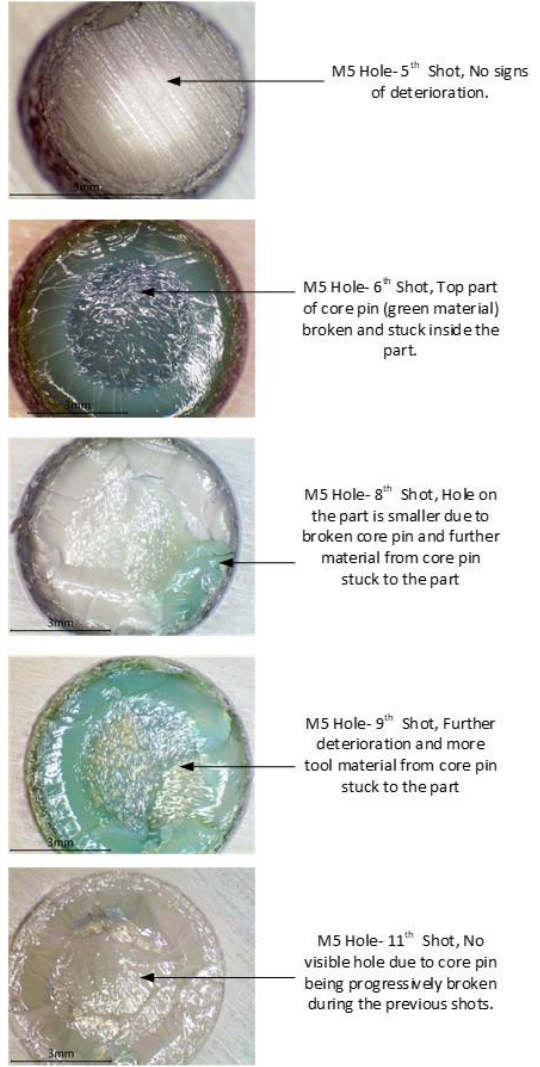
Figure 23. Progressive reduction in depth of the M5 core hole as a result of deterioration of the M5 core pin. (The green material is the core pin that been chipped and stuck onto the part during ejec- tion).